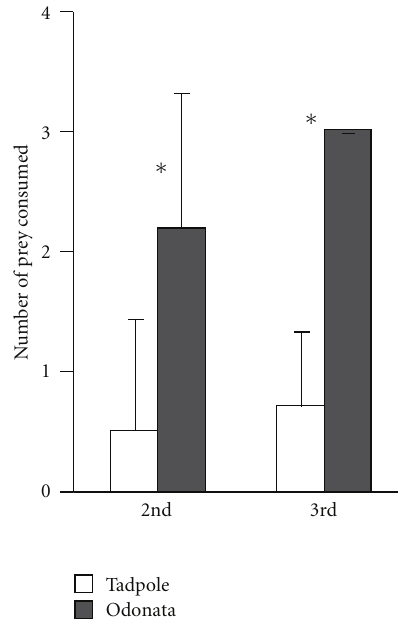
Figure 1: The number of tadpoles and Odonata nymphs consumed by Cybister tripunctatus orientalis larvae. ∗ P < 0 . 05, the Wilcoxon signed-rank test. Data are shown as the mean +